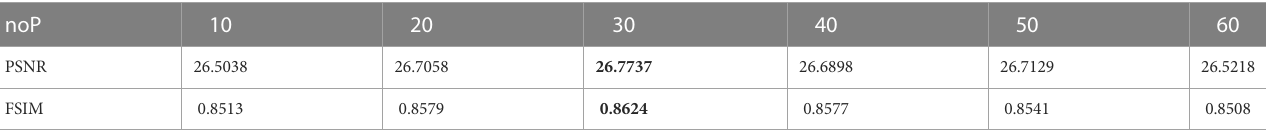
TABLE 2 Effect of experimental results by noP.